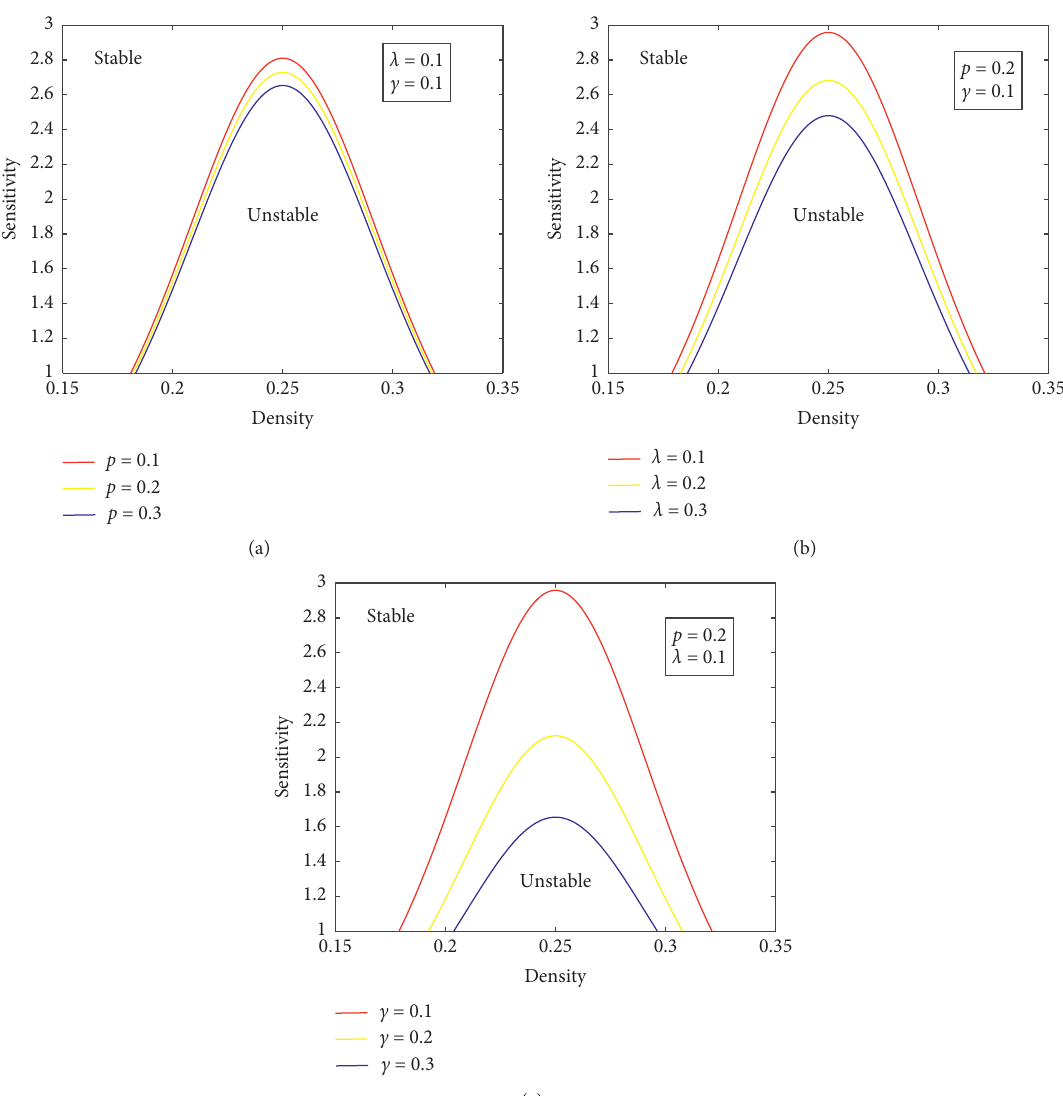
Figure 2: Phase diagram in ( ρ , a ) space for (a) p � 0 . 1 , 0 . 2 , 0 . 3 with λ � 0 . 1 , c � 0 . 1. (b) λ � 0 . 1 , 0 . 2 , 0 . 3 with p � 0 . 2 and c � 0 . 1. (c) c � 0 . 1 , 0 . 2 , 0 . 3 with p � 0 . 2 and λ � 0 . 1.